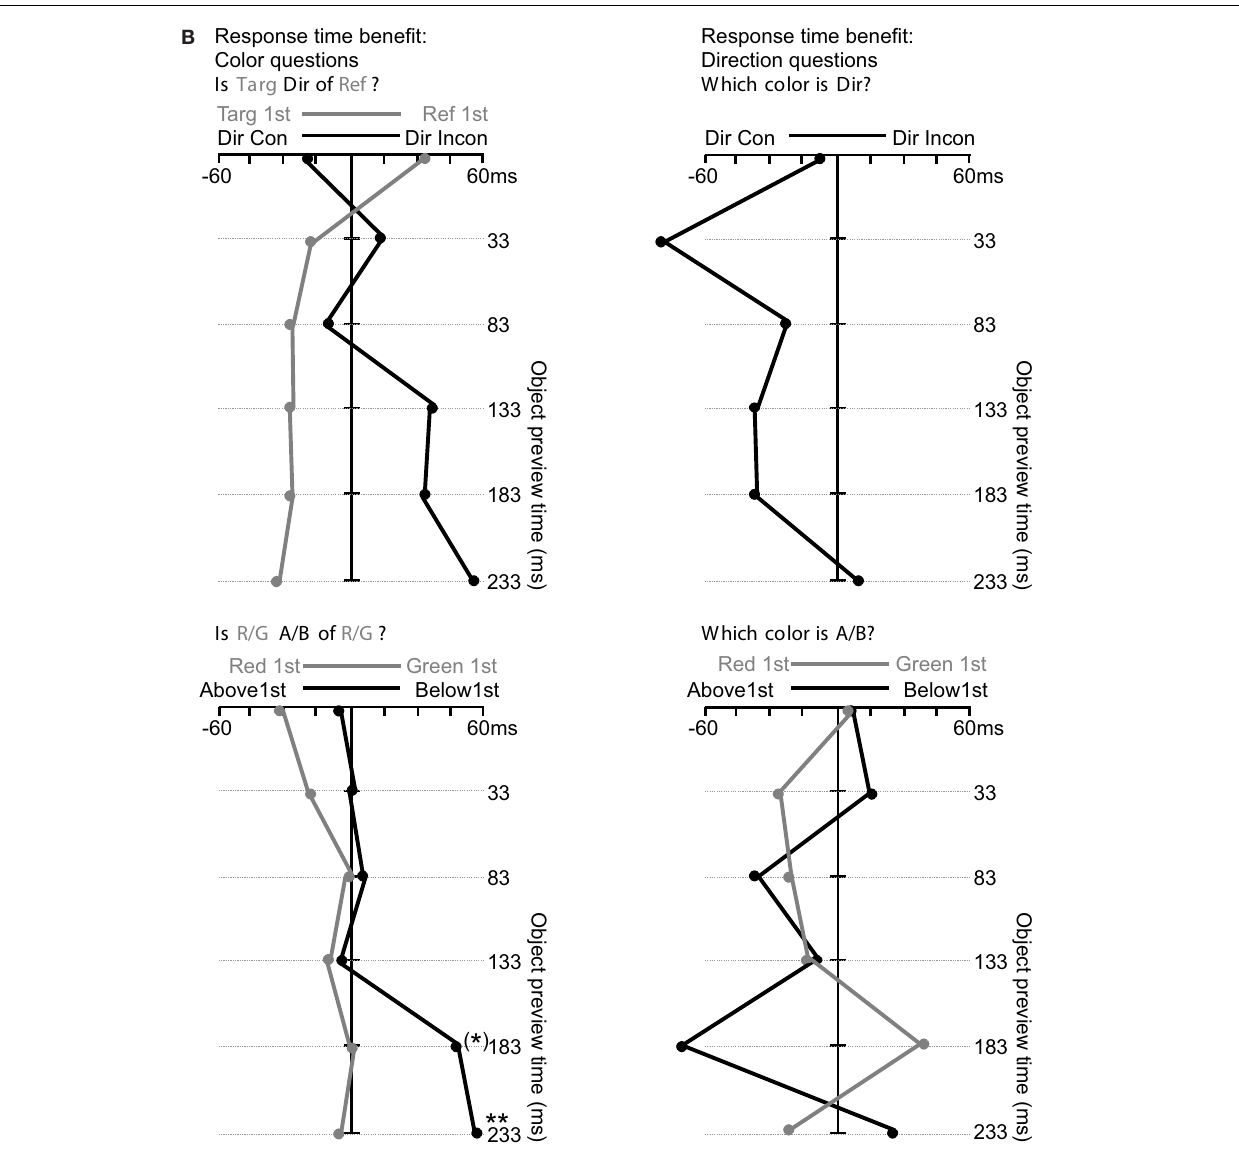
FIGUREA2 | (A) Response time results for Experiment 1 (Left/Right relations). **Indicates an effect passing Bonferroni correction p < 0.008 (*), indicates 0.008 < p < 0.05. (B) Response time results for Experiment 2 (above/below relations). **Indicates an effect passing Bonferroni correction p < 0.008 (*), indicates 0.008 < p <